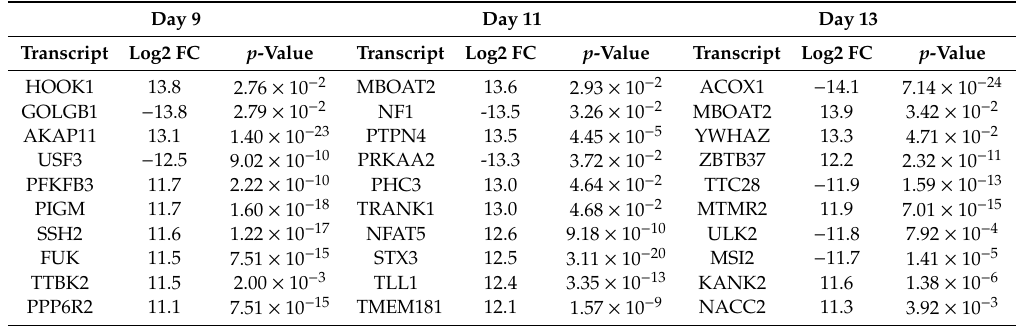
This table demonstrates the top ten annotated transcripts for each day ranked based upon the fold change (FC). A positive fold change indicates higher abundance in samples from pregnant mares and a negative fold